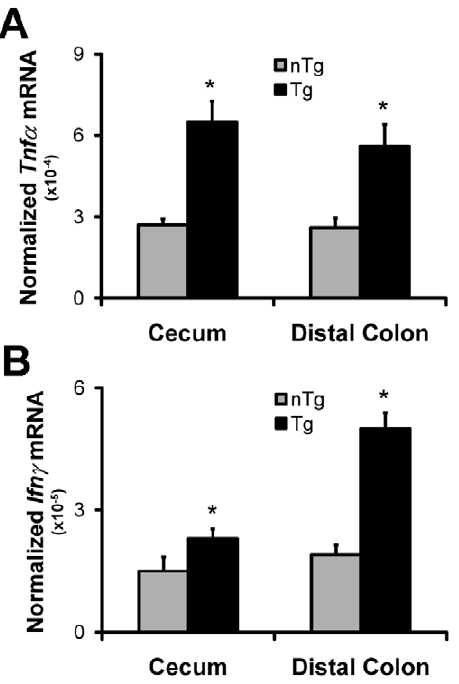
Figure 2. Expression of Pro-Inflammatory Cytokines in Colon Tissue from B.theta Monoassociated Rats. Abundance of TNF a (A) and IFN c (B) mRNA normalized to b -actin as measured by real-time RT- PCR in cecum and distal colon tissue from 6-week monoassociated non- transgenic (nTg) and HLA-B27 transgenic (Tg) rats (mean + SEM, *p , 0.05, n=4 rats/group).